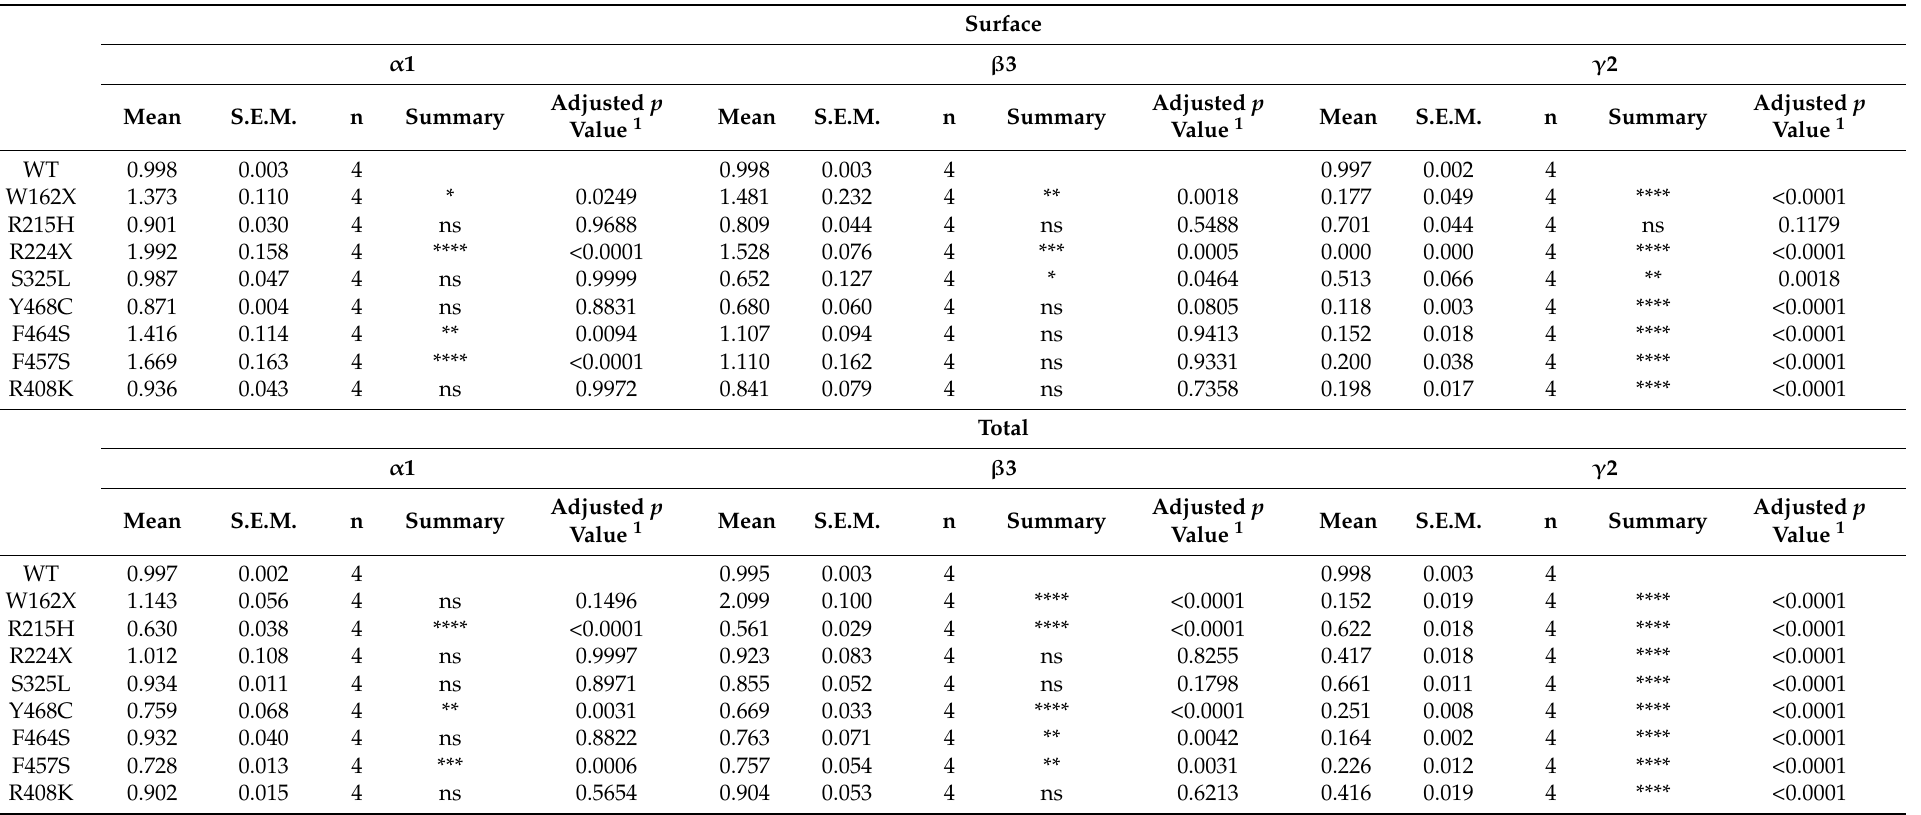
Table 5. Effects of GABRG2 variants on α 1 β 3 γ 2 receptor